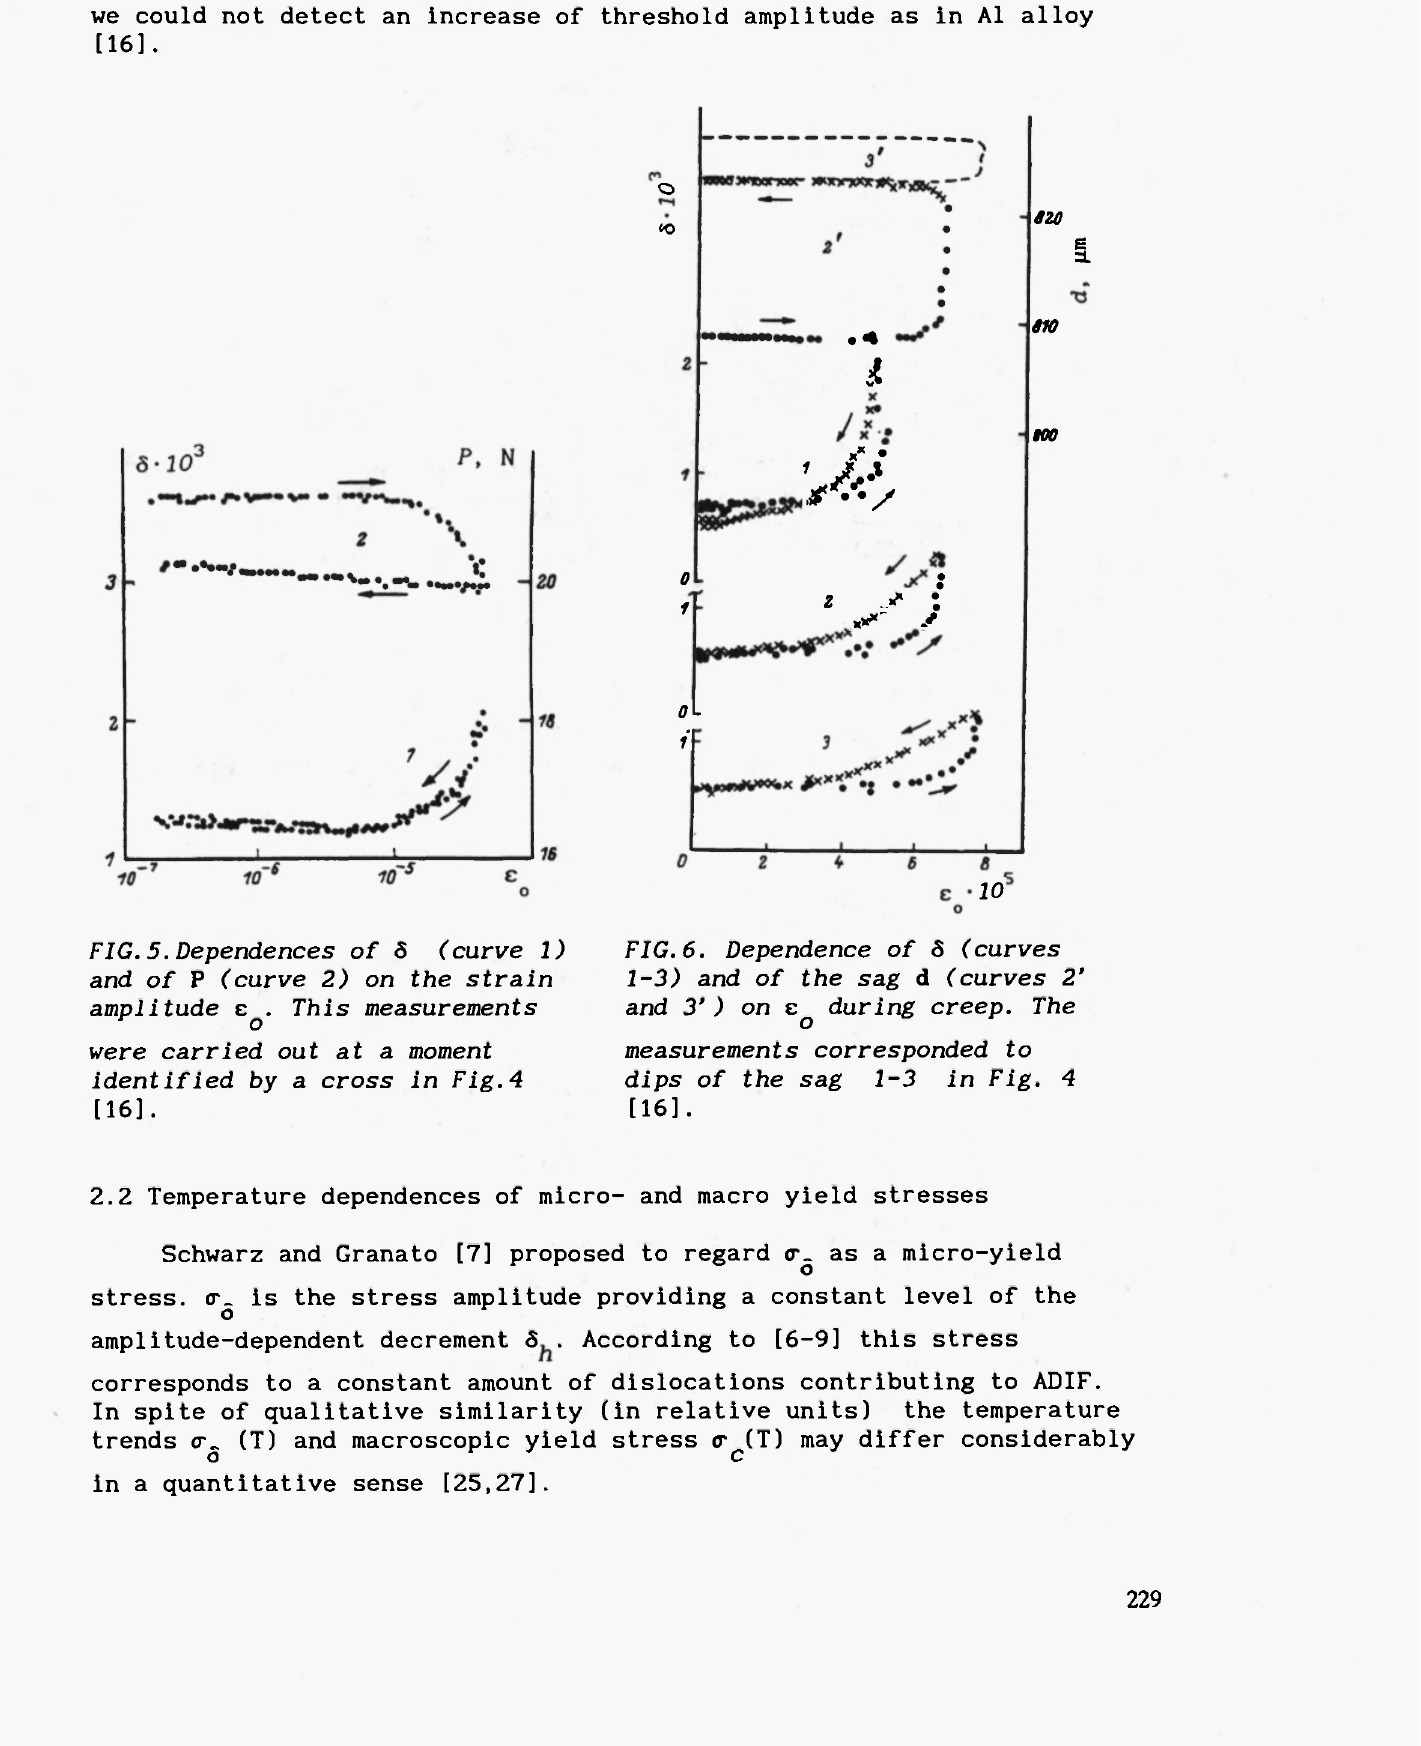
FIG. 6. Dependence of δ (curves 1-3) and of the sag d (curves 2' and 3' ) on c^ during creep. The measurements corresponded to dips of the sag 1-3 in Fig. 4